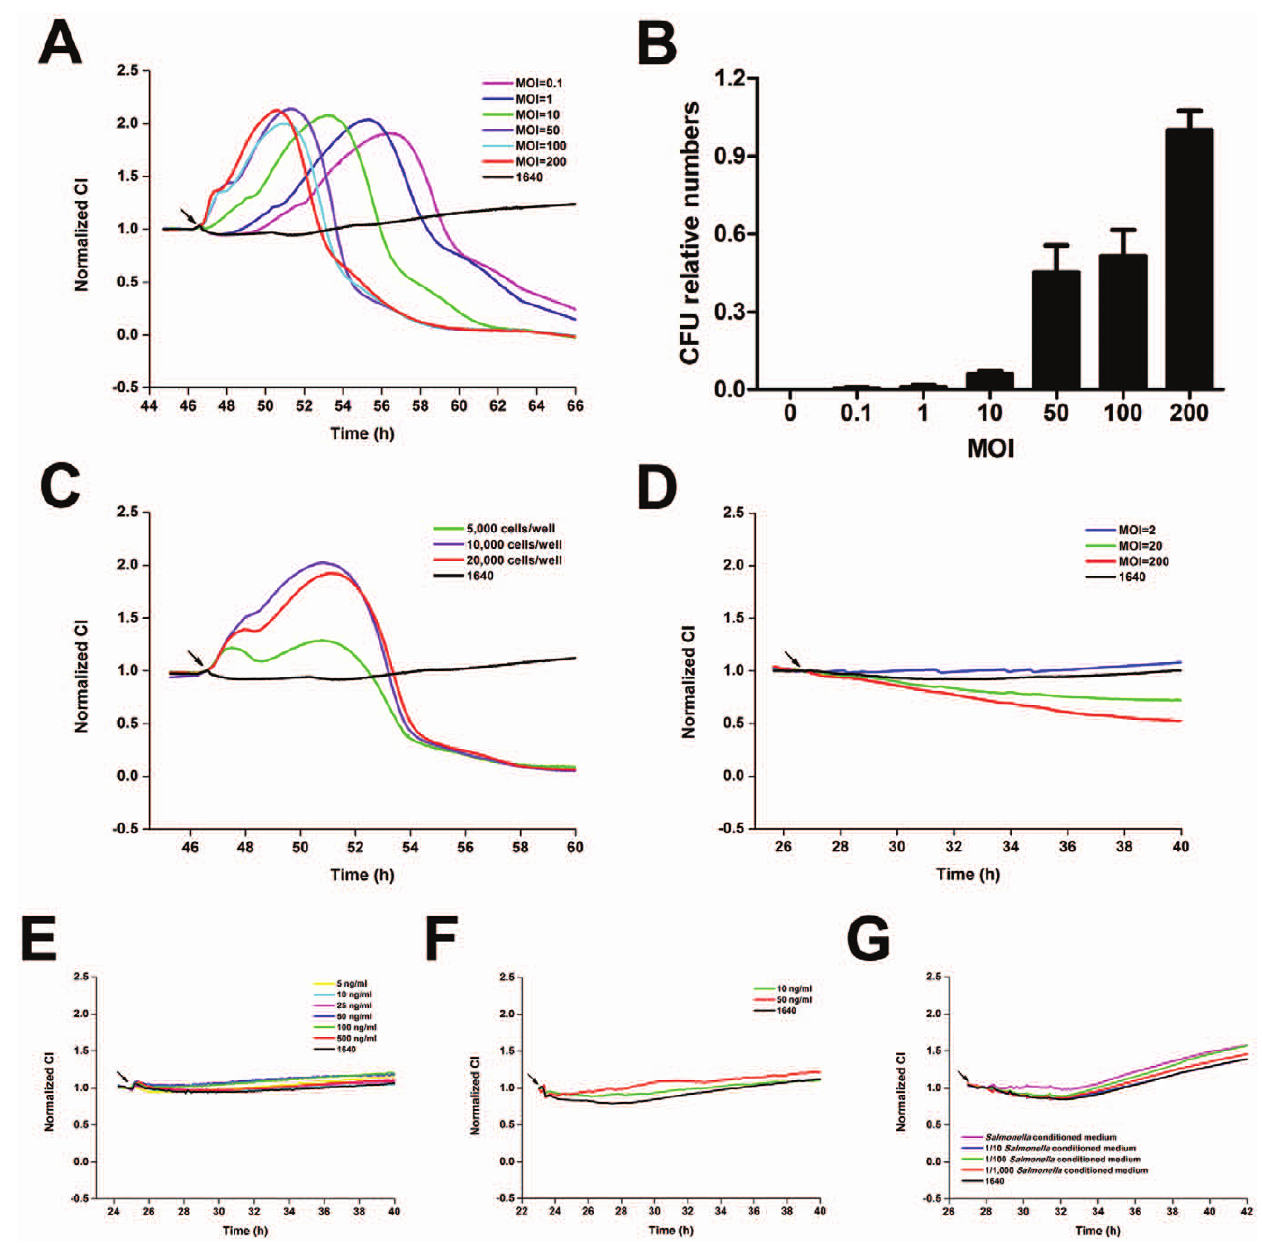
Figure 1. Dynamic monitoring of intestinal epithelial cell responses to Salmonella infection. (A) HT-29 cells (10,000 cells per well) were seeded into E-plates and infected with MOIs 0.1, 1, 10, 50, 100, or 200 of S. typhimurium . (B) Effect of increasing MOI on invasive bacterial count. The number of intracellular bacteria in cells infected with S. typhimurium at MOI of 200 was sets as 1.0. Results are mean values 6 S.E.M from three independent experiments done in triplicate. (C) Initial inoculums of 5,000, 10,000, or 20,000 cells per well of HT-29 cells were seeded into E-plate wells. Fixed amounts (2 6 10 6 cfu) of S. typhimurium were added. (D) TCRPs of HT-29 cells in response to S. typhimurium bacterial components or culture products. HT-29 cells (10,000 cells per well) were seeded into E-plates. The next day, cells were treated with heat-inactivated bacteria (D), LPS (E), flagellin (F) or conditioned medium of S. typhimurium (G) and CIs were continuously monitored every 5 min. Arrows in all figures represent time points after bacteria or stimulator addition. Representative curves are an average of four replicate wells. doi:10.1371/journal.pone.0026544.g001 larger than uninfected cells, indicating that the second peak was (Figure 3A.b, and Figure S2.b). From 1.5 h to 3 h after infection associated with cellular enlargement induced by bacterial (phase c, d of TCRP), the actin cluster (or accumulation) could not replication. At 7 h after infection, membrane rupture was seen be detected (Figure 3A.c–d). This actin re-arrangement correlated with the rise of the second peak, as evidenced by the enlargement in cell shapes (phase e). Membrane ruffling and formation of Salmonella -containing vacuoles (SCVs) were visualized at 5 h after infection (Figure 3A.e, Figure S2.e). The size of infected cells was